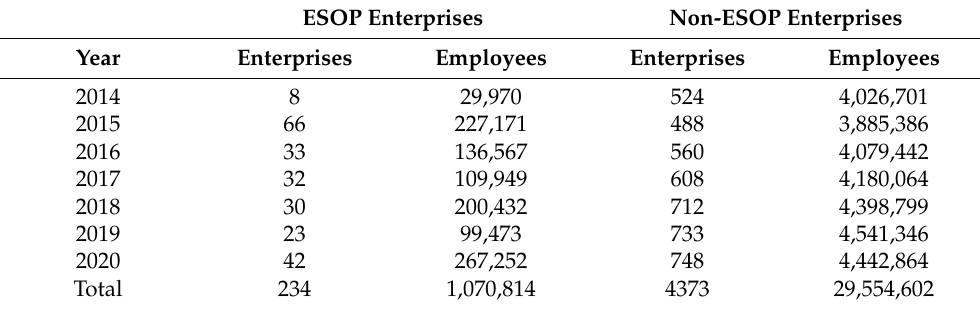
Table A3. The number of enterprises and employees by ESOP.